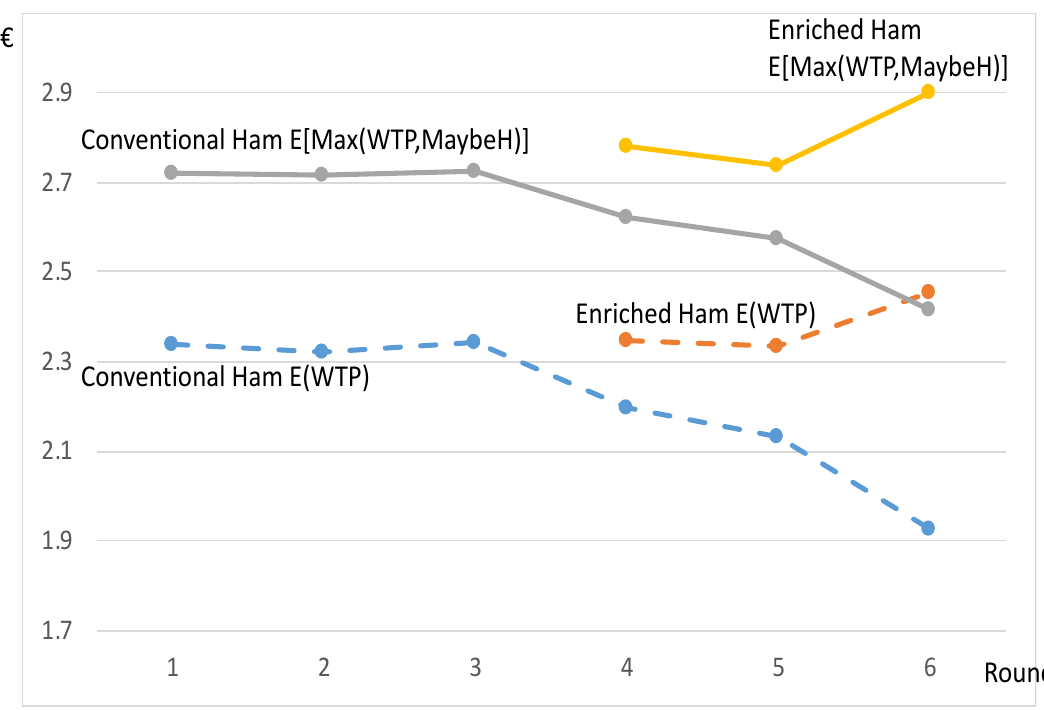
Figure 3. Average Max[WTP,MaybeH] and average WTP for Hams (€).